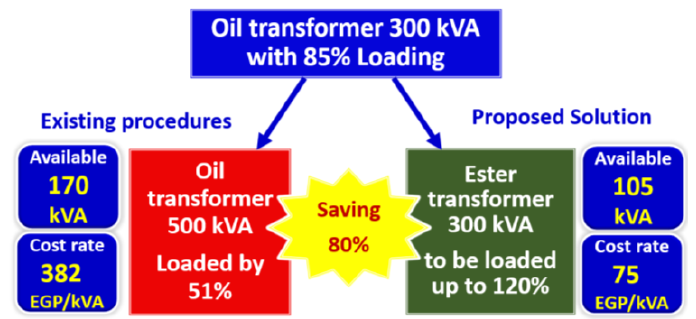
Figure 13. Economic feasibility for 300 kVA SE-immersed DT.